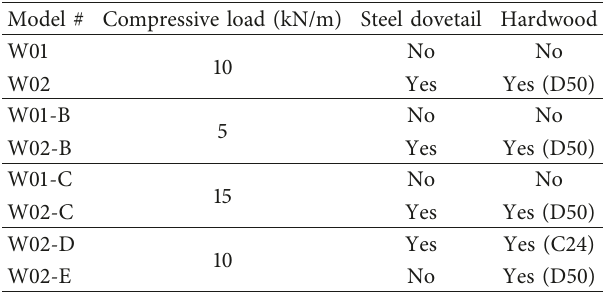
Table 1: Selected configurations for the FE parametric study. Model # Compressive load (kN/m) Steel dovetail Hardwood